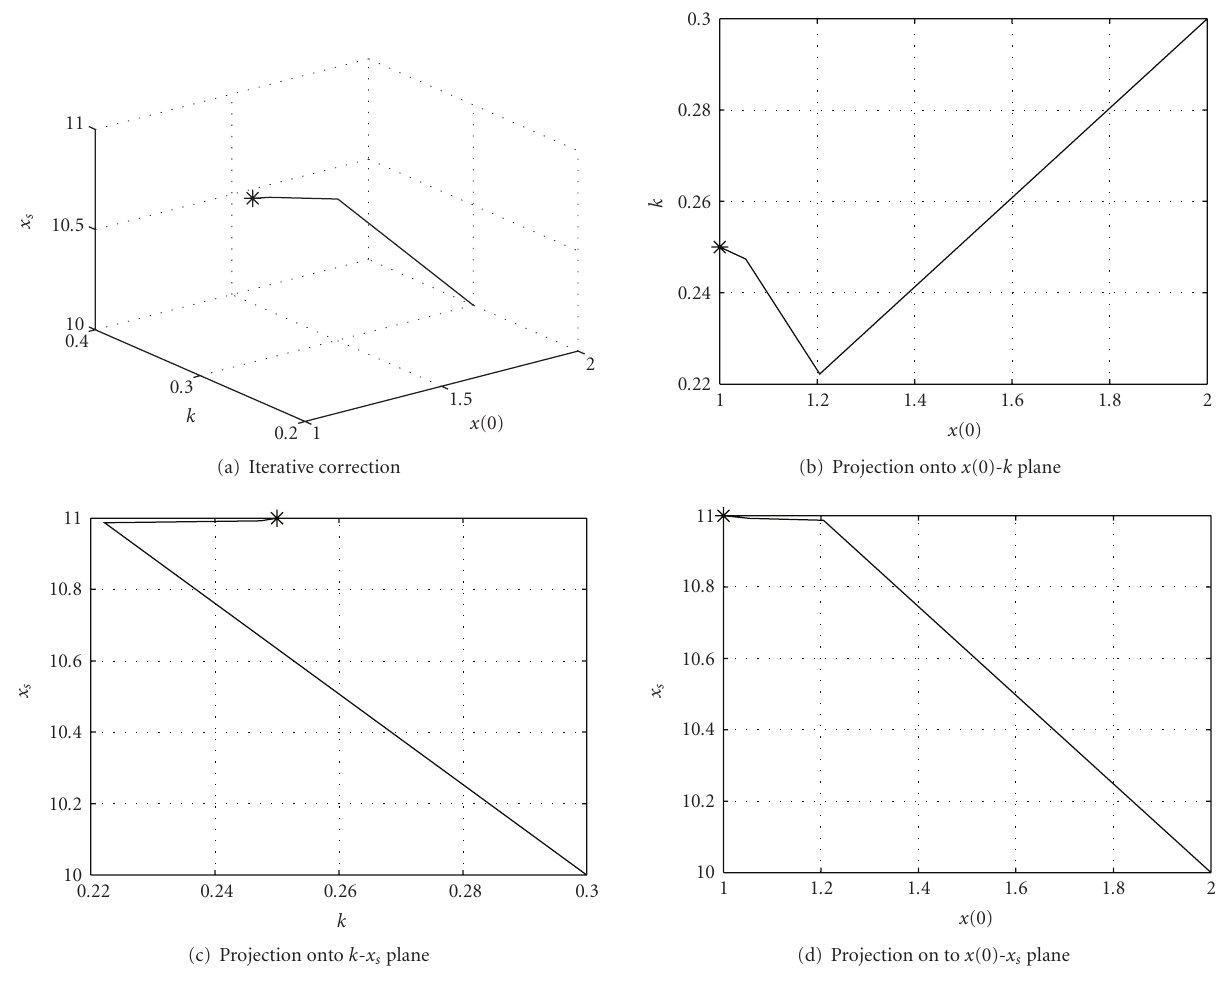
Figure 3: An illustration of the progression of first-order iterative corrections using six observations at t = 2, 7, 12, 17, 22, and 27.